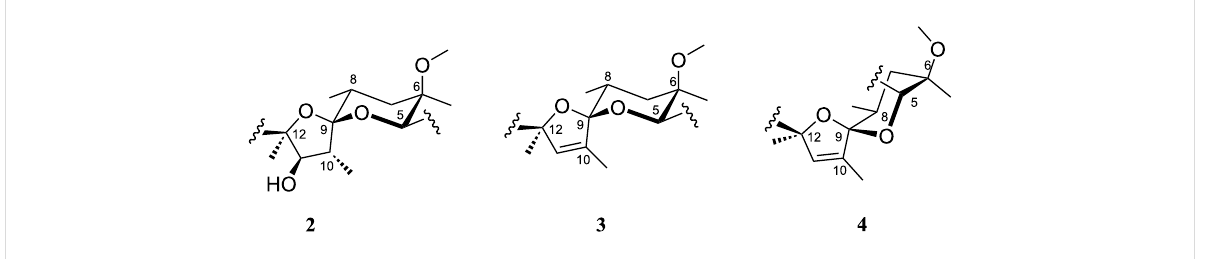
Figure 6: Comparison of the spiroketal ring system stereochemistry and conformations in compounds 2 – 4 .